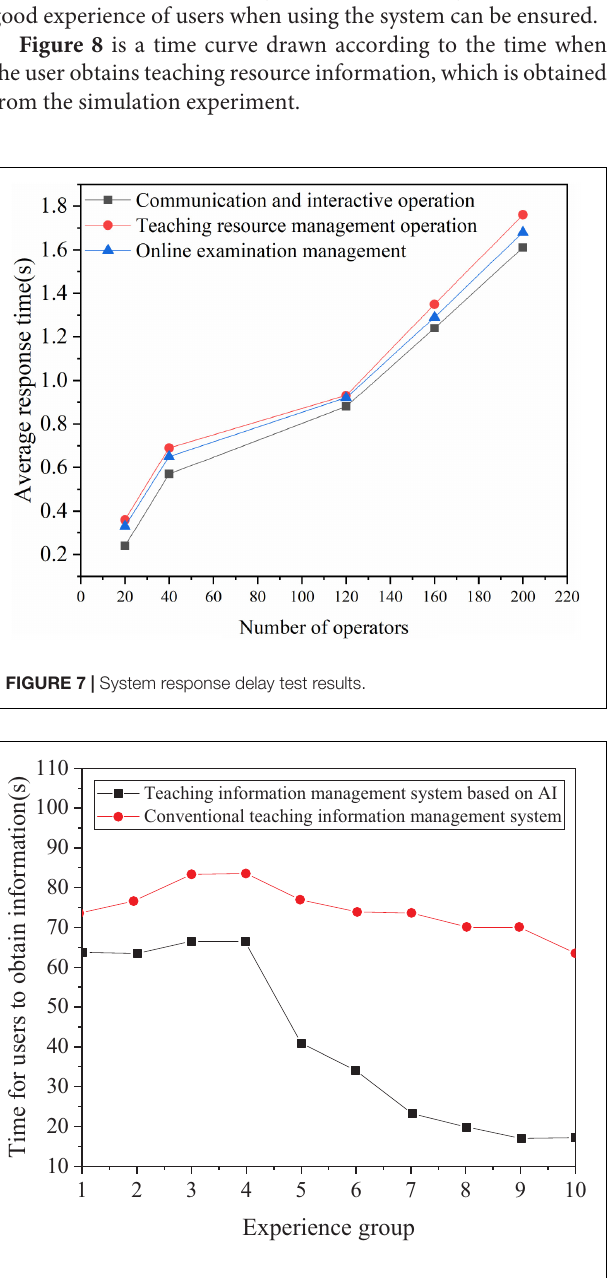
FIGURE 8 | Time curve of users to obtain network teaching